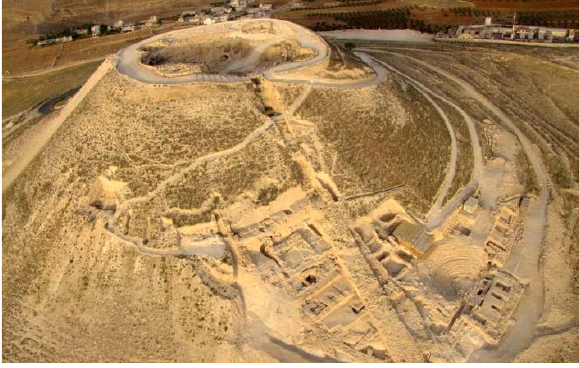
Figure 1. An aerial photograph of the excavation area on the northern slope (Netzer et al., 2010)